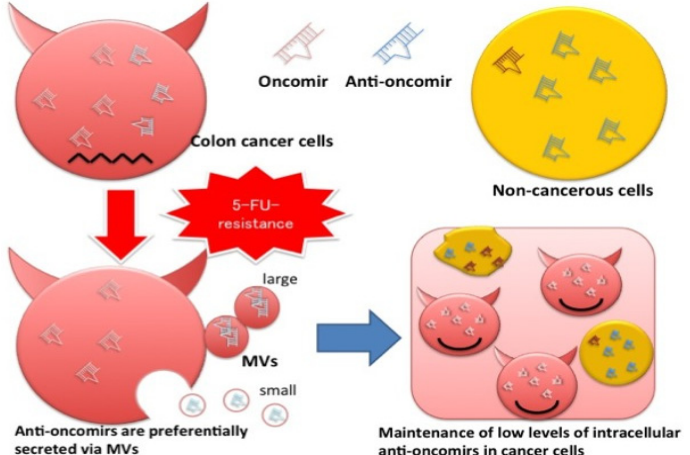
Figure 5. Schematic diagram of machinery for drug resistance in DLD-1/5FU